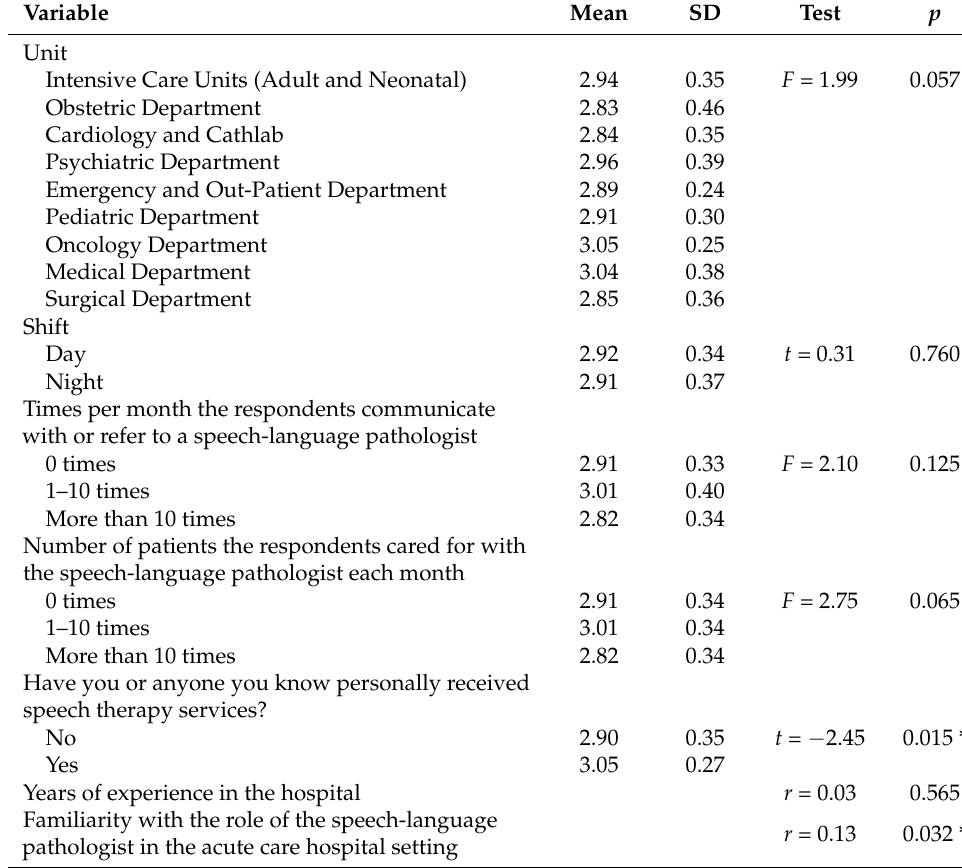
Table 3. Results of the Tests for Differences and Associations between the Work-Related Characteris- tics and Perceptions of the Value of Speech-Language Pathology (N =